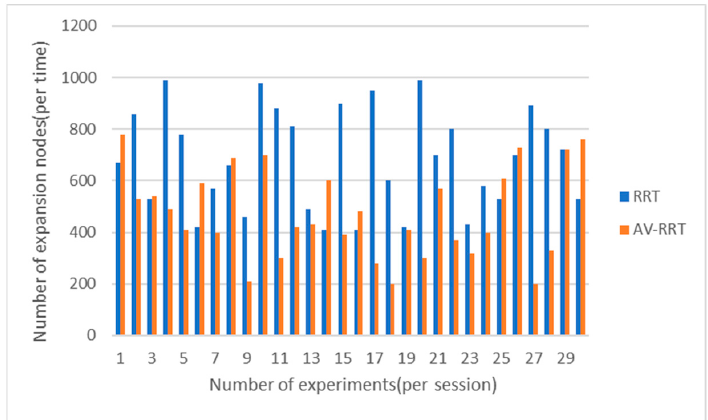
Figure 14. Comparison of number of extended nodes in scene with sparse obstacles.